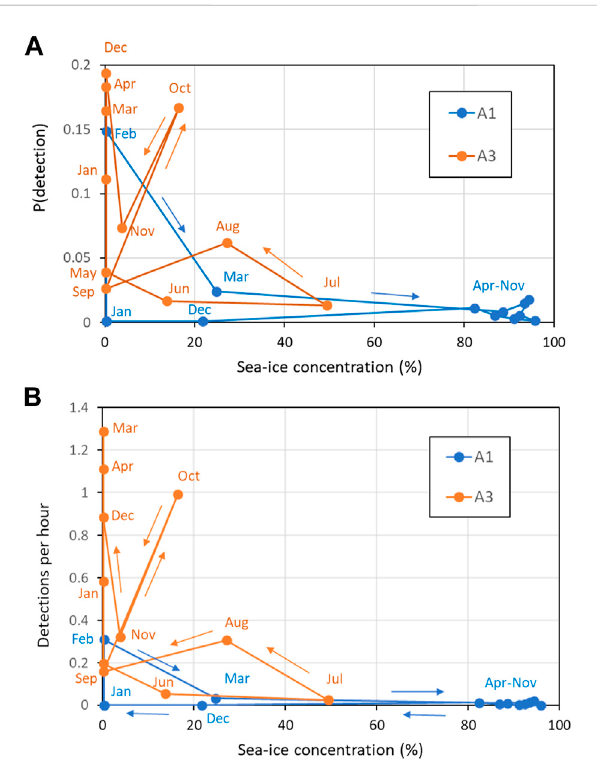
FIGURE 11 Effect of distance to open water ( < 15% ice concentration) on (A) Mean probability of detection in an hour; (B) Mean hourly detection rate. Key months are labelled (see colour for site). Coloured lines connect months in date order as shown by the